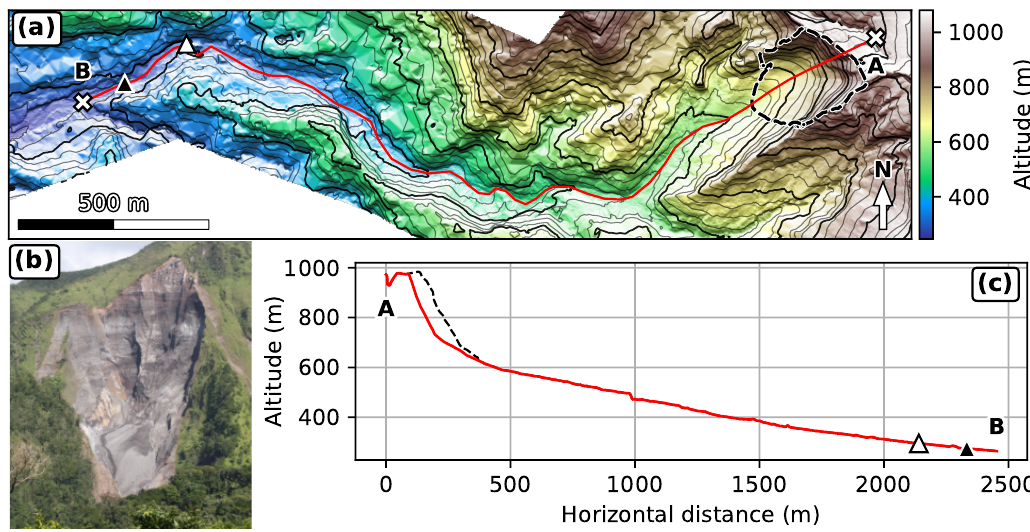
Figure 2. Samperre cliff destabilizations. ( a ) August 2018 topography, 1 m DEM. Black dashed outline: extent of destabilized area (difference between 2010 and 2018 DEMs). Bold contour interval is 100 m. Red line: cross-section along which travel distances are measured. Black triangle: observed travel distance in 2009. White triangle: observed travel distance in 2018. ( b ) Picture of the Samperre cliff (black dashed outline in ( a )) taken in February 2018 (OVSM). ( c ) Cross-section along red line in ( a ). Red line: Post-collapse topography with deposits removed. Black dashed line: Topography in July 2010. Black and white triangles are reported from ( a